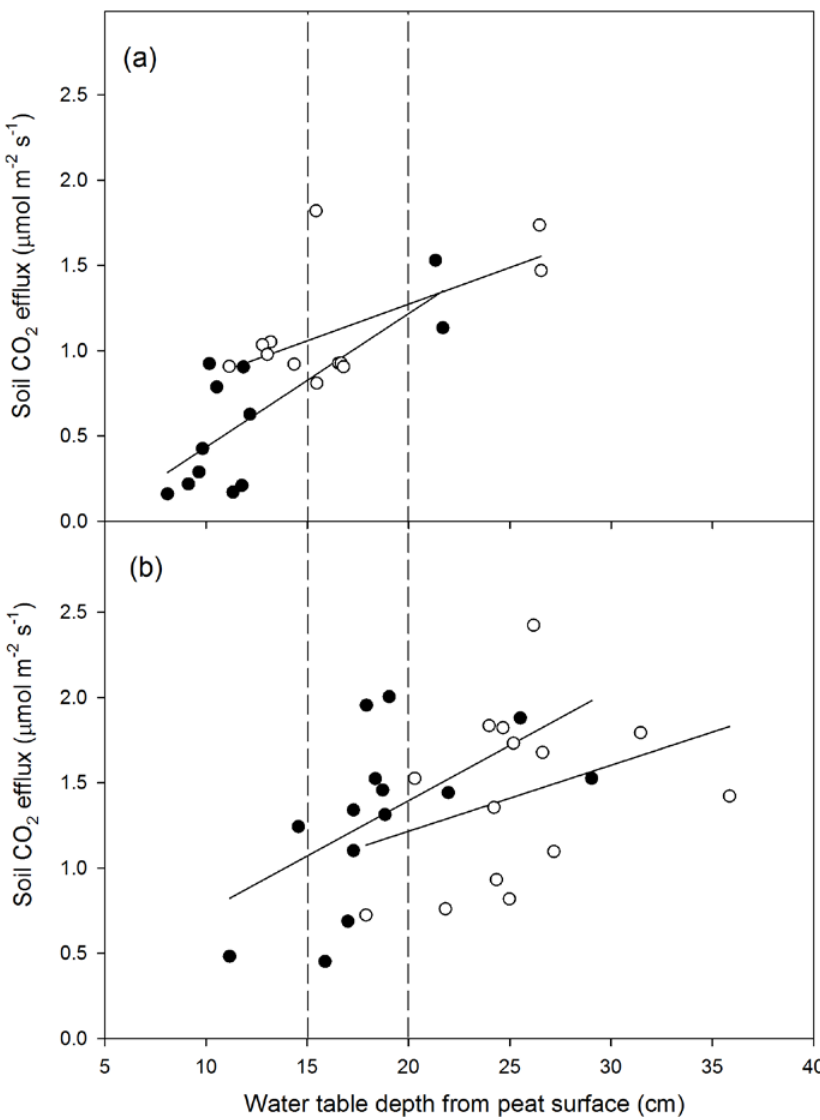
Figure 6. Regression of water table depth (cm) versus soil CO 2 efflux (µmol m -2 s -1 ) in (a) 2009 and (b) 2010. Solid circles = control, open circles = sheltered. Vertical dashed lines indicate the range of the proposed water table tipping